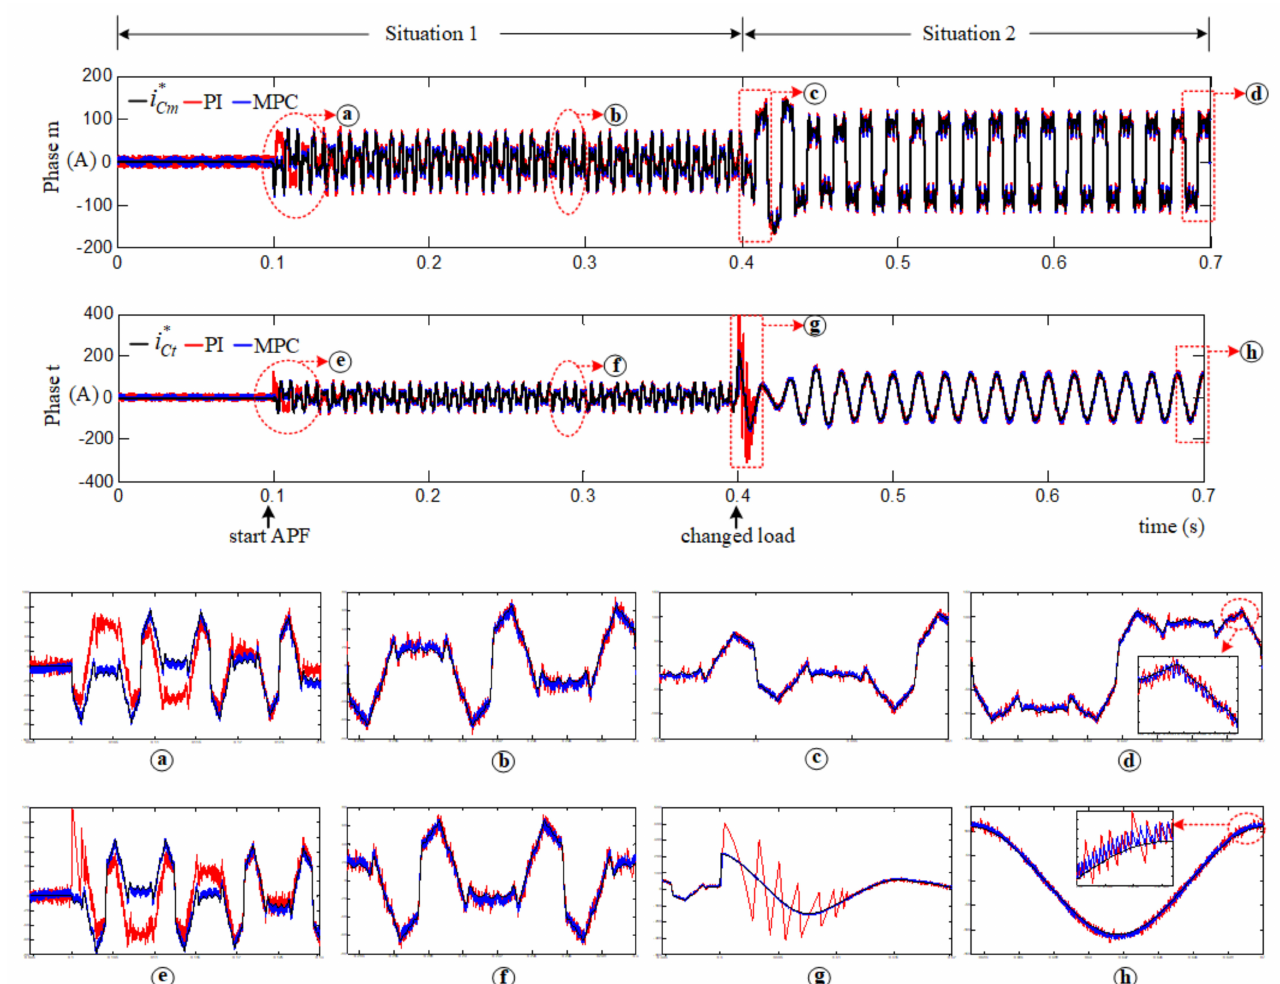
Figure 8. The tracking performance of the compensating